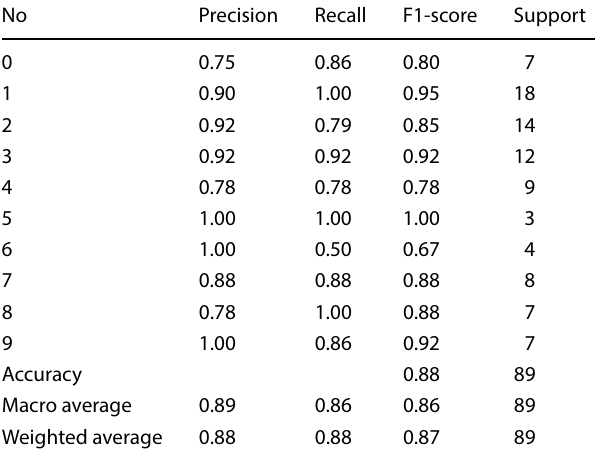
Table 3 K-Nearest Neighbors (KNN) result using the confusion matrix No